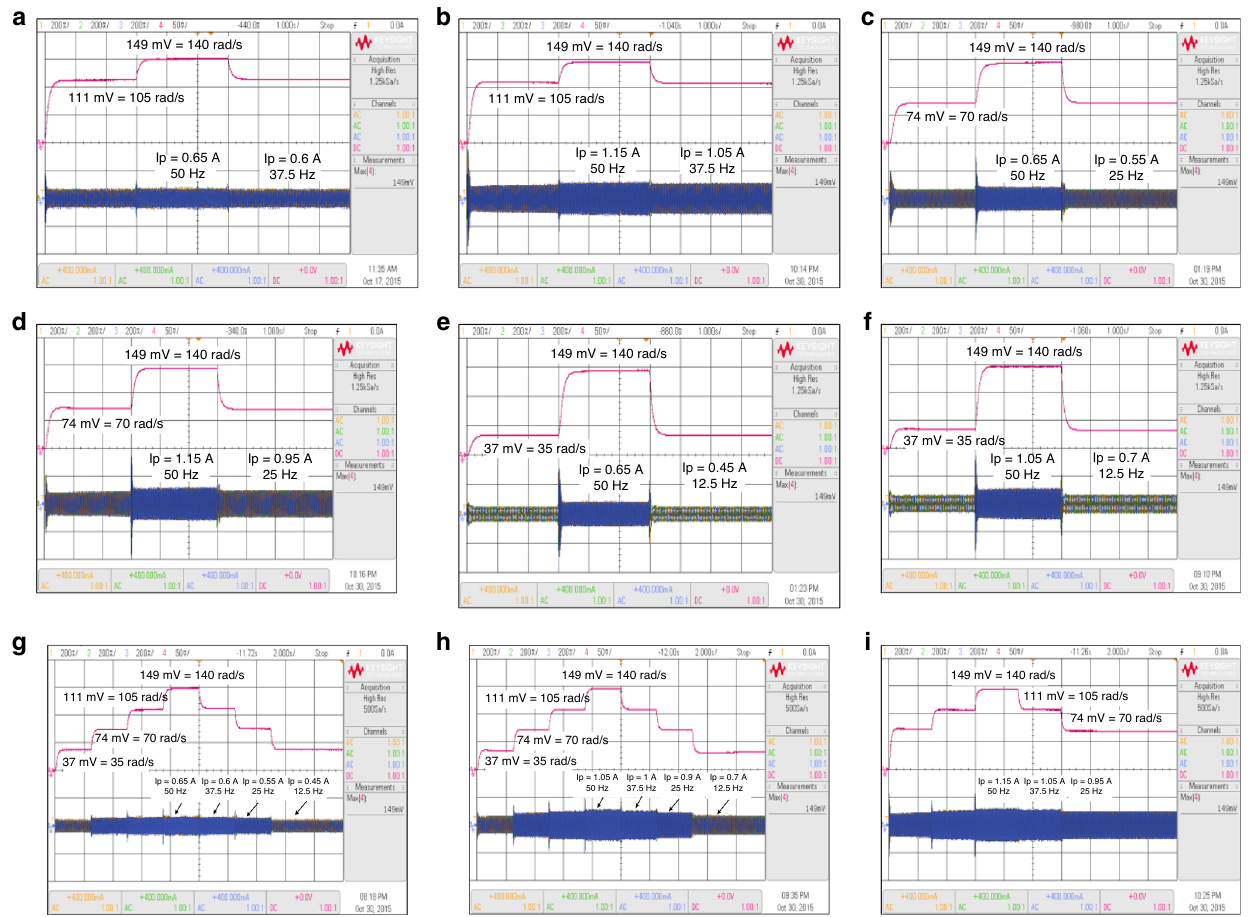
Fig. 5 Experimental results under step response test and down-to-up-to-down test. a QLSA performance in step response test under the speed varying from 105 rad/s to 140 rad/s with no-load. b QLSA performance in step response test under the speed varying from 105 rad/s to 140 rad/s with 2 Nm load. c QLSA performance in step response test under the speed varying from 70 rad/s to 140 rad/s with no-load. d QLSA performance in step response test under the speed varying from 70 rad/s to 140 rad/s with 2 Nm load. e QLSA performance in step response test under the speed varying from 35 rad/s to 140 rad/s with no-load and, f QLSA performance in step response test under the speed varying from 35 rad/s to 140 rad/s with 1 Nm load. g QLSA performance in down-to-up-to-down test under the speed varying from 35 rad/s to 70 rad/s, from 70 rad/s to 105 rad/s and from 105 rad/s to 140 rad/s at no-load. h . QLSA performance in down-to-up-to-down test under the speed varying from 35 rad/s to 70 rad/s, from 70 rad/s to 105 rad/s, from 105 rad/s to 140 rad/s at 1 Nm load. i QLSA performance in down-to-up-to-down test under the speed varying from 70 rad/s to 105 rad/s, from 105 rad/s to 140 rad/s at 2 Nm